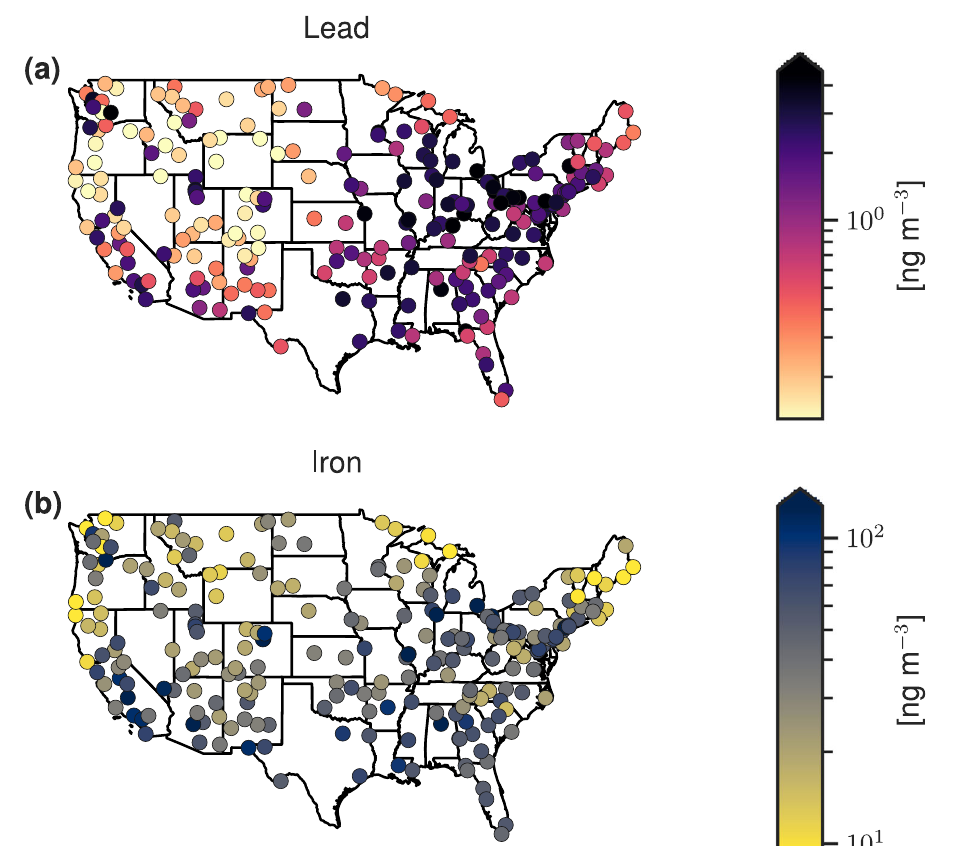
Fig. 1 | Geographic distribution of fi ne particulate metals. a Lead (representing anthropogenically-emitted metals) and b iron (representing non-anthropogenically- emitted metals) annual (year 2019) mean mass concentrations in PM 2.5